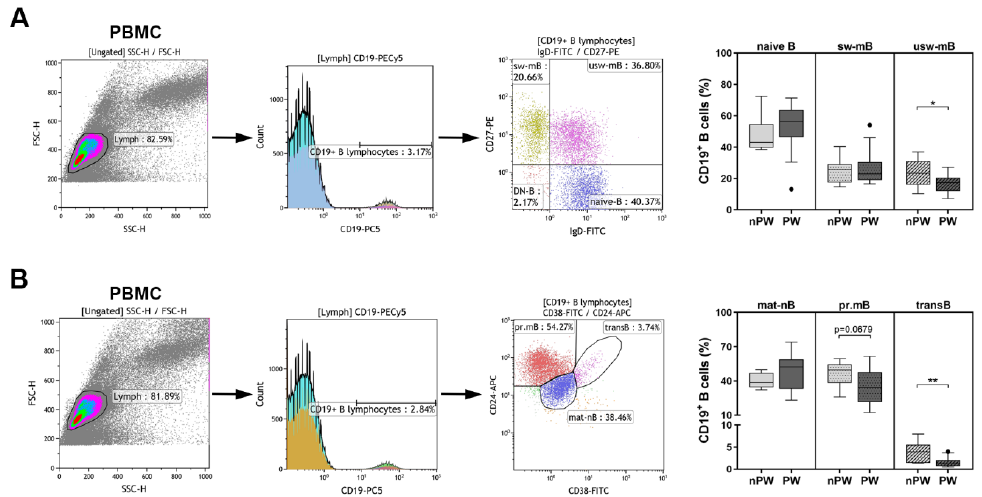
Figure 2. PBMCs were isolated from 14 healthy pregnant women (PW) and 7 healthy non-pregnant women (nPW), then they were stained with fluorochrome-labelled antibodies as described previously. Representative dot plots and histograms show the gating strategy of different B cell subsets ( A , B ). ( A ) Percentages of naïve B, switched memory B (sw-mB) and un-switched memory B (usw-mB) cells. ( B ) Frequencies of mature–naïve B (mat-nB), primarily memory B (pr.mB) and transitional B (transB) cells. Box plots represent the interquartile range (IQR) with a line in the middle as the median value. Statistically significant differences are indicated by * p < 0.05 and ** p < 0.01. As there is no uniform consensus in Breg identification methods and the overlap be- tween different B cell subset specific markers makes their determination even more diffi- cult, we also measured the expression of CD5 and CD1d markers on the surface of B cells (Figure 3A). The percentages of CD5 + B-1a cells (12.93 ± 6.87 vs. 5.43 ± 1.74; p = 0.0127) and the frequencies of CD5 + CD1d + Breg cells (9.38 ± 5.22 vs. 4.53 ± 1.42; p = 0.0193) significantly decreased in pregnant women compared to non-pregnant controls (Figure 3B). Since hu- man Bregs were described as being CD19 + CD24 hi CD38 hi as well, a correlation analysis was performed between the percentages of transitional B cells and B-1a or Breg cells. Both B- 1a ( R = 0.7418; p = 0.0051) and Bregs ( R = 0.6593; p = 0.0169) showed a significant positive correlation with CD24 hi CD38 hi B cells (Figure 3C).